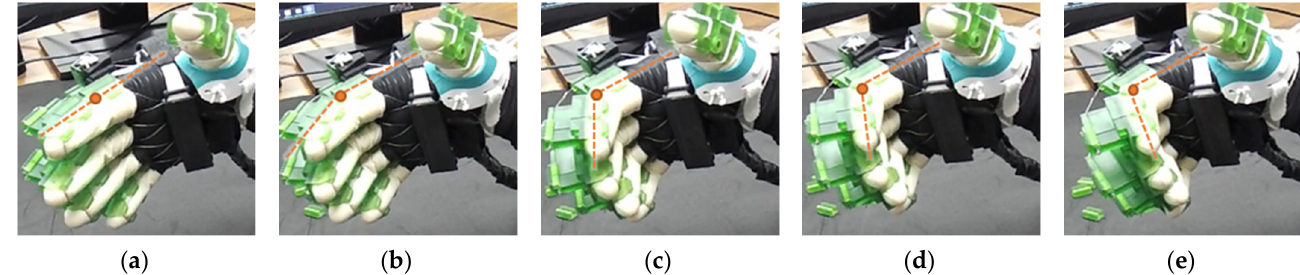
Figure 18. Fingers’ PIP flexion: ( a ) index, middle, ring, and small finger PIP joints are extended, PIP joint angle: 0°; ( b – d ) Figure 18. Fingers’PIPflexion: ( a )index, middle, ring, andsmallfingerPIPjointsareextended, PIPjointangle: 0 ◦ ; ( b – d )intermediate